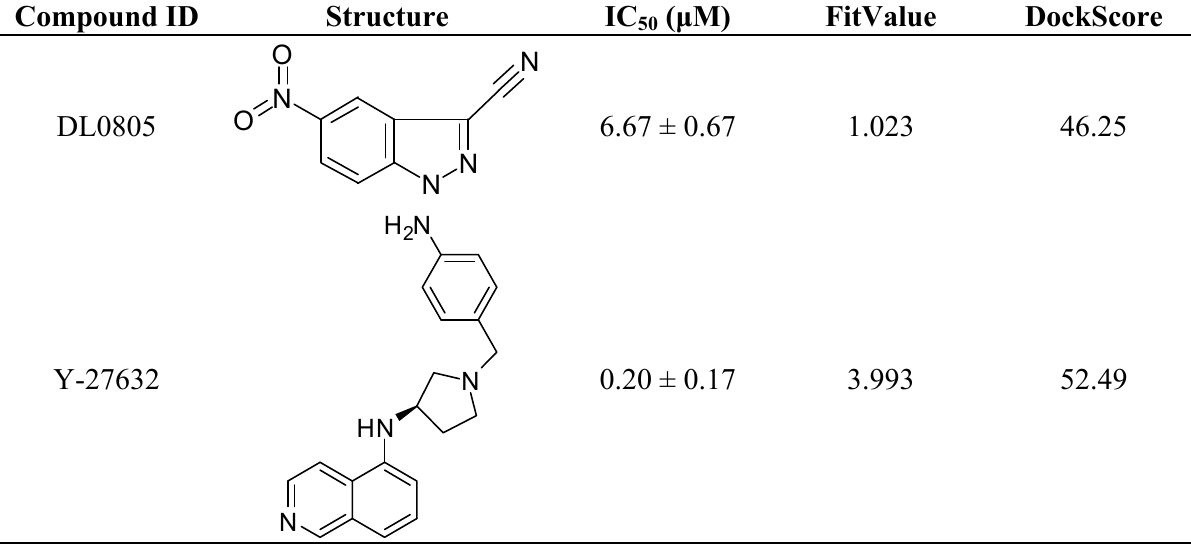
Table 1. ROCK-I inhibitors identified by virtual screening and high-throughput screening. Pharmacophore-Fit Value, LigandFit-Dock Score, and IC